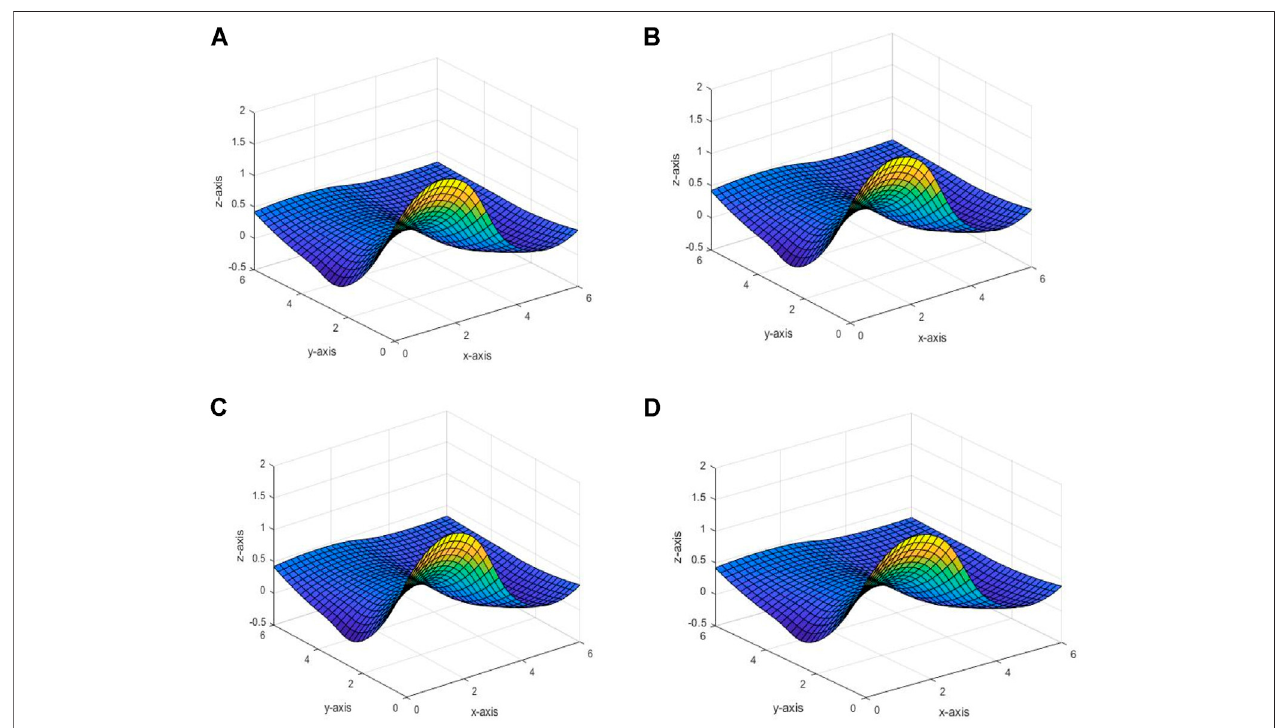
FIGURE 4 | Stability of the rational quartic interpolant. (A) α i , j (cid:2) β i , j (cid:2) (cid:4) α i , j (cid:2) (cid:4) β i , j (cid:2) 100 . (B) α i , j (cid:2) β i , j (cid:2) (cid:4) α i , j (cid:2) (cid:4) β i , j (cid:2) 1000 . (C) c i , j (cid:2) (cid:4) c i , j (cid:2) 0 . 005 . (D) c i , j (cid:2) (cid:4) c i , j (cid:2) 0 . 0005 .